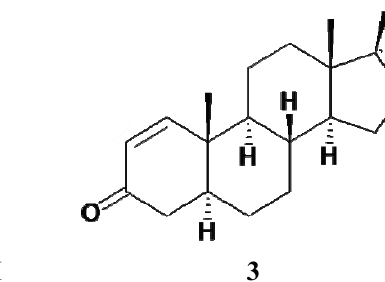
Table 1. 1 H (700 MHz, CDCl